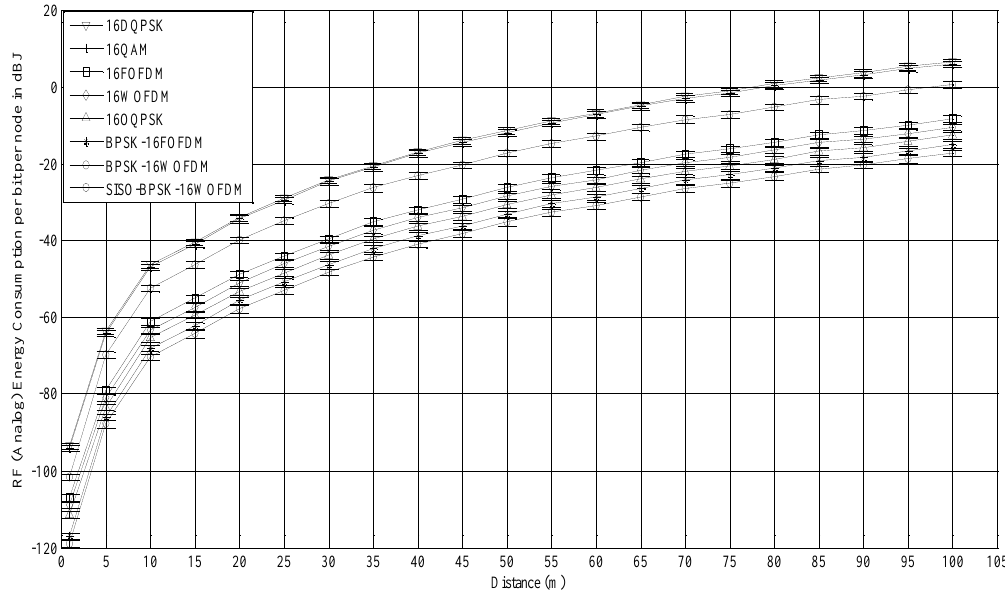
Figure 8. Total energy per bit per node over transmission distance to 100